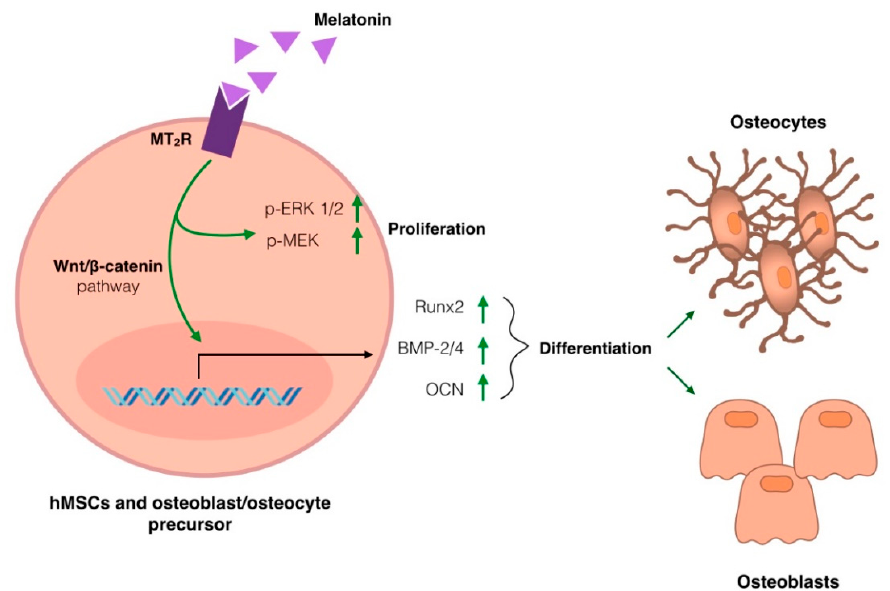
Figure 1. Molecular mechanism underlying melatonin’s anabolic effect on bone density. Melatonin binding to its G-protein coupled receptor (MT 2 R), located on the cell membrane of hMSCs and pre-osteoblasts, induces a signaling cascade that leads to the phosphorylation of MEK and ERK1/2 and, favoring (green arrows) cell proliferation and the upregulation of factors involved in cell differentiation via Wnt/ β -catenin signaling pathway. The factors involved in controlling the bone formation and osteoblasts and osteocyte differentiation from precursor cell lines are bone morphogenetic proteins 2 and 4 (BMPs), runt-related transcription factor 2 (Runx2) and osteocalcin